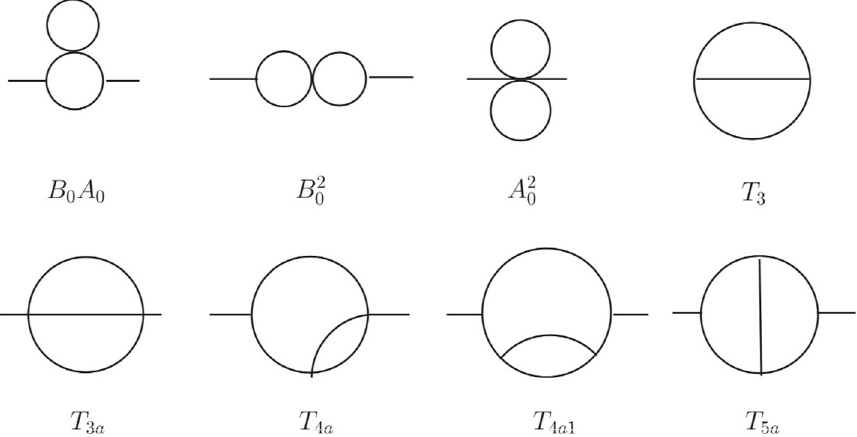
Figure 2 . The master integral basis chosen in our calculation, with notation taken from